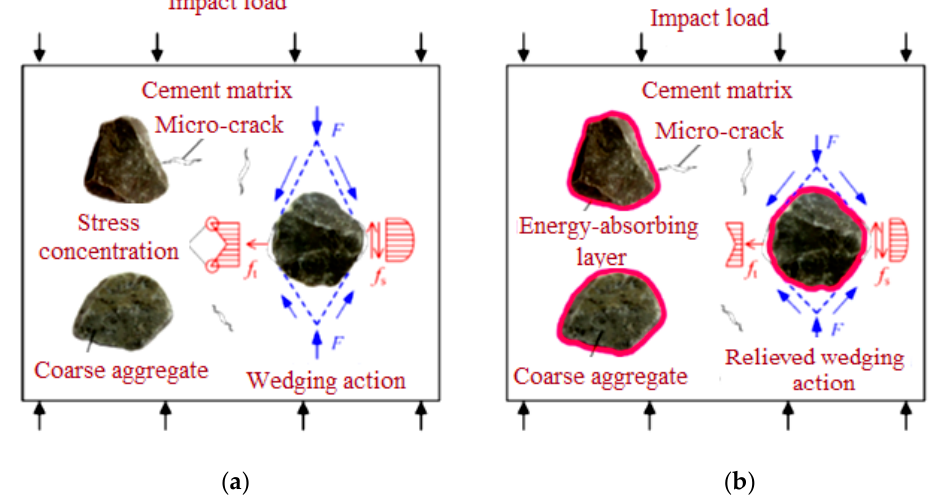
Figure 1. Schematic drawing of coarse aggregate failure ( a ) natural; ( b ) asphalt coated.